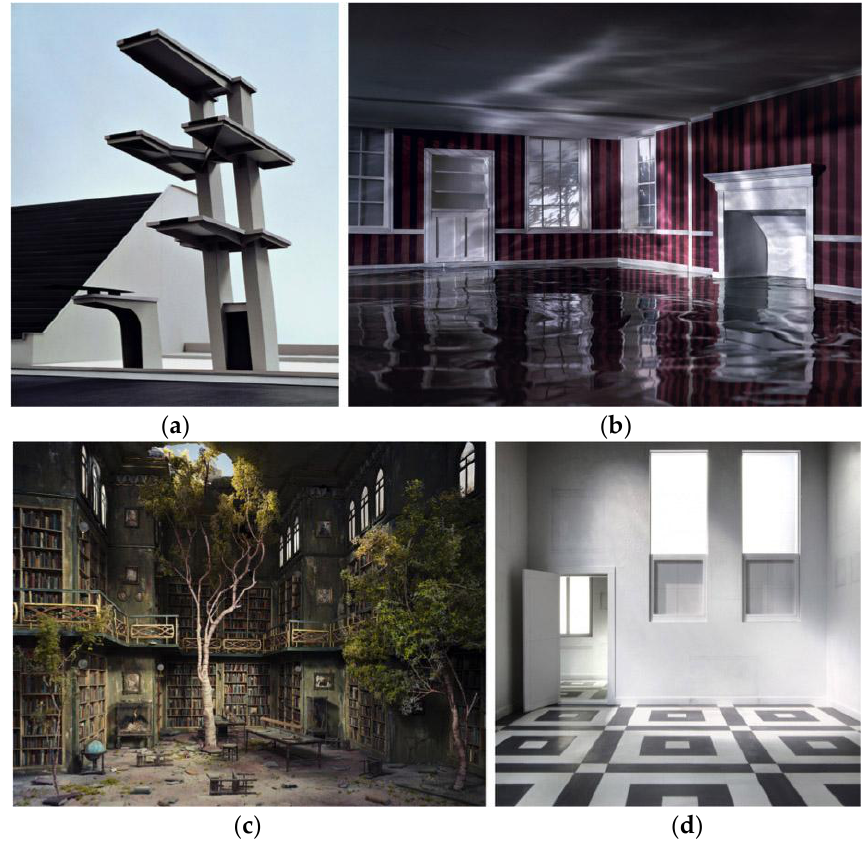
Figure 6. ( a ) Thomas Demand, Sprungturm , 1994; ( b ) James Casebere, Red Room , 2003; ( c ) Lori Nix, Library , 2007; ( d ) Emilio Pemjean, Oudezijds Voobugwal 320, Amsterdam ,